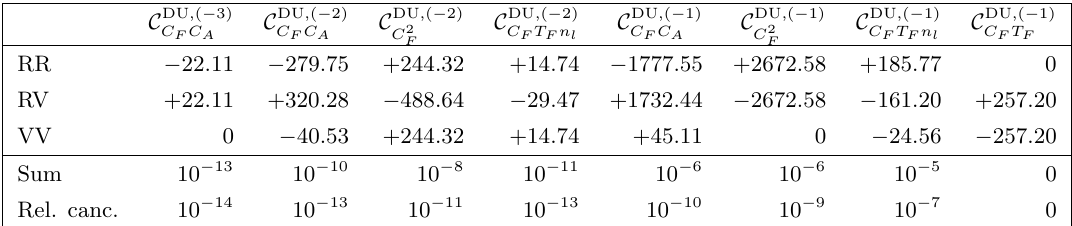
Table 1. Numerical values of the pole coe(cid:14)cients of the double-unresolved term as de(cid:12)ned in eq. (4.27). The numerical values correspond to m b = 4 : 78 GeV, M H = 125 : 09 GeV and the renormalisation scale is (cid:22) R = 3 M H . Each column corresponds to a particular colour structure of a given (cid:15) pole. The three rows correspond to the double-real, real-virtual, and double-virtual contri- butions. In the last two rows, we report the absolute and relative level of cancellation after adding up RR + RV + VV contributions. The last row is normalised to the largest value of each